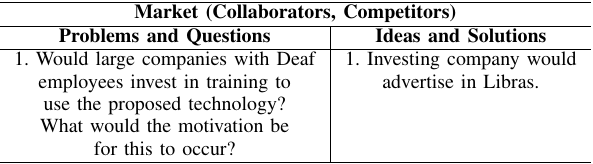
TABLE IV E VALUATION F RAME RESULTS FOR THE S OURCE LAYER